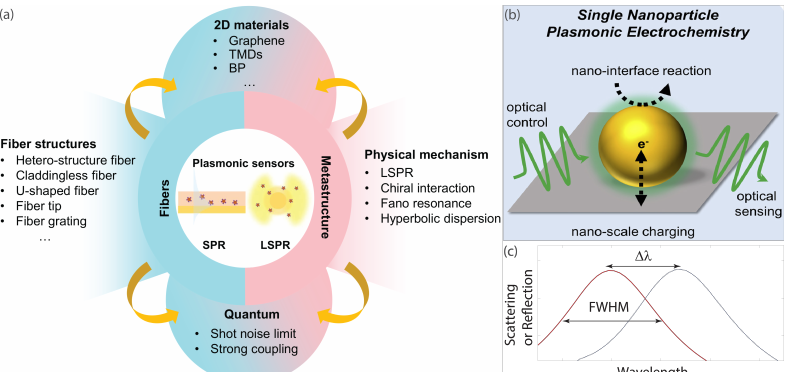
Figure 9. The development of surface plasmon sensors has made significant progress in recent years, particularly in planar metastructures and optical-fiber waveguides. ( a ) Broad application of plasmonic nanostructures in sensing enabled by their remarkable ability to confine light at the nanoscale and support the excitations of surface plasmon resonances (denoted ‘SPR’) or localized surface plasmon resonances (denoted ‘LSPR’) with associated effects and sensitivity to the environment. Optical nanostructures with LSPR, hyperbolic dispersion, Fano resonance, and integration with two- dimensional (denoted ‘2D’) materials in the metastructure platform have recently been introduced. The integration of optical-fiber sensors with LSPR/SPR structures and two-dimensional materials has been achieved. Quantum plasmonic sensing has surpassed the conventional shot-noise limit, demonstrating significant progress in the field. Although these surface plasmon designs bring countless opportunities in this field, they also come with challenges, which are discussed in the main text. ( b ) A simple plasmonic sensing geometry consists of a nanoparticle on a substrate. ( c ) When illuminated with light of a particular wavelength, the nanoparticle exhibits a characteristic scattering spectrum that follows a Lorentzian lineshape with a clearly defined resonance wavelength λ r and full width at half maximum (FWHM). ( a ) Reproduced from [5]. ( b ) Reproduced with permission from [132] Copyright 2018 by